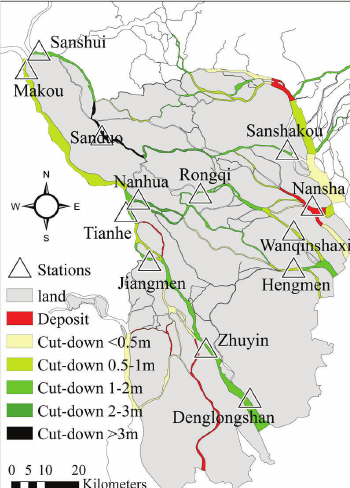
Figure 3: Change of maximum cut depth in Pearl River Delta from 1985 to